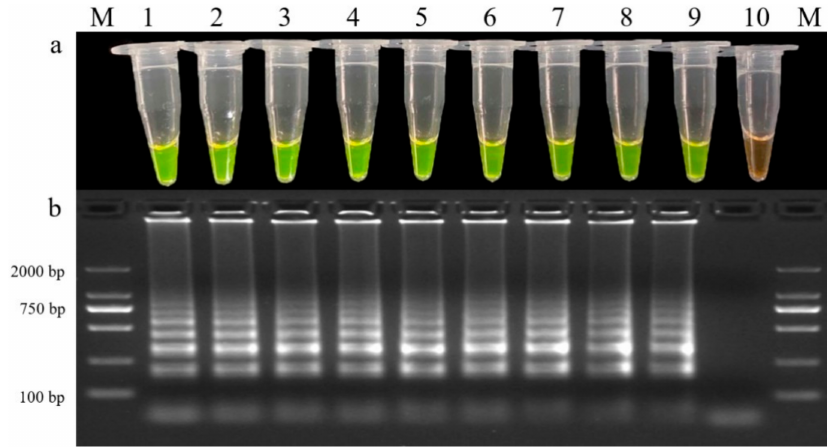
Figure 5. Profiles of LAMP reactions for P. graminea with different temperatures. Assessments of LAMP products based on SYBR Green I visualization of color change ( a ) or agarose gel electrophoresis ( b ). Lane M, DNA ladder; tubes and lanes 1 to 9, LAMP reaction with temperatures of 58, 59, 60, 61, 62, 63, 64, 65, and 66 ◦ C, respectively; tube and lane 10, negative control with ddH 2 O at 65 ◦ C. LAMP products showed positive amplification when incubated for 50 to 70 min in both gel electrophoresis and SYBR Green staining (Figure 6a,b). Slightly faint bands were observed in agarose gel detection when incubated for 70 min. Robust bands were observed in gel electrophoresis after incubation for 60 min. Therefore, the optimal reaction time in the LAMP assay was 60 min to ensure amplification efficiency.